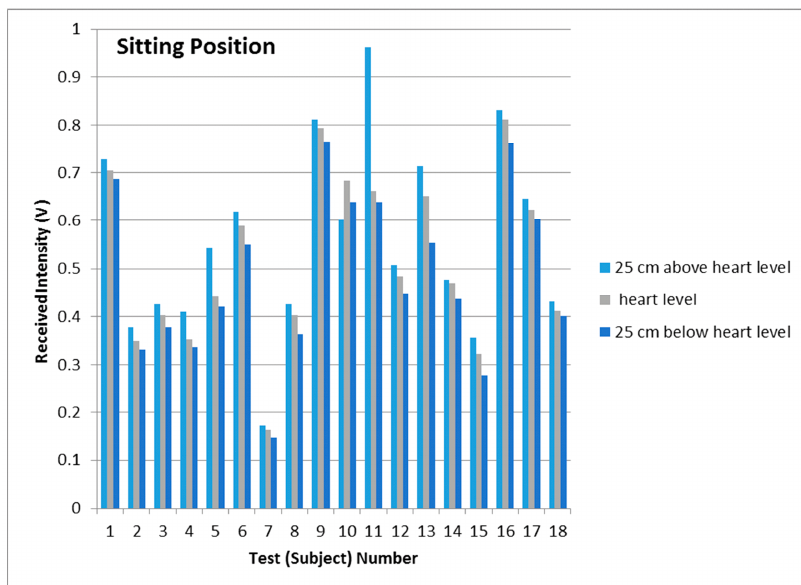
Figure 9. PPG baseline amplitudes for 18 subjects whilst in the sitting position and the finger sensor probe set at three different vertical levels.